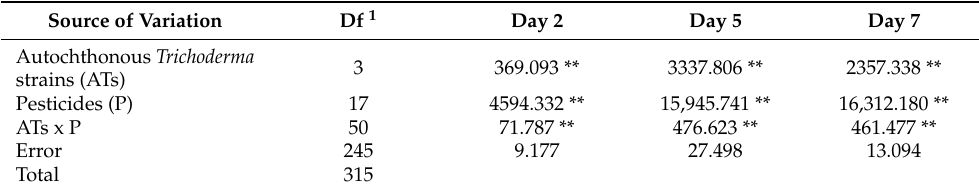
Table 4. Mean squares of two-way ANOVA (autochthonous Trichoderma strains and all pesticides) for Trichoderma